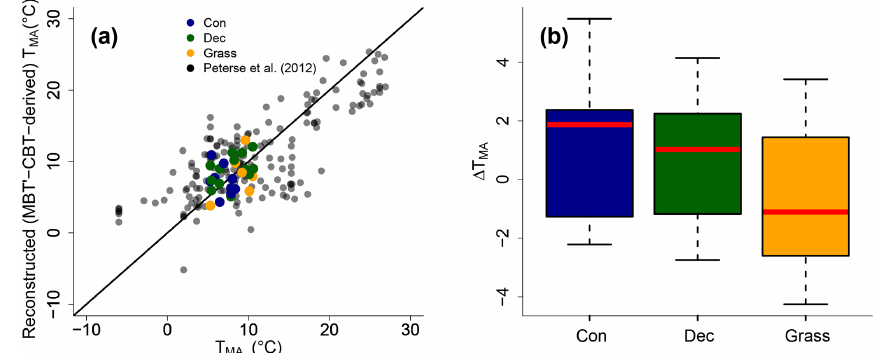
Figure 6. (a) Correlation between climate station T MA and reconstructed (MBT (cid:48) –CBT-derived) T MA . For comparison, the global calibration dataset from Peterse et al. (2012) is shown. The black line indicates the 1:1 relationship. (b) Box plots of (cid:49)T MA (refers to reconstructed T MA − T MA from climate stations) in the different vegetation types from our transect study. Box plots show the median (red line), interquartile range (IQR) with the upper (75%) and lower (25%) quartiles, lowest whisker still within 1.5 IQR of the lower quartile, and highest whisker still within 1.5 IQR of the upper quartile; dots mark outliers. Abbreviations: con: coniferous forest sites ( n = 9); dec: deciduous forest sites ( n = 14); grass: grassland sites ( n =